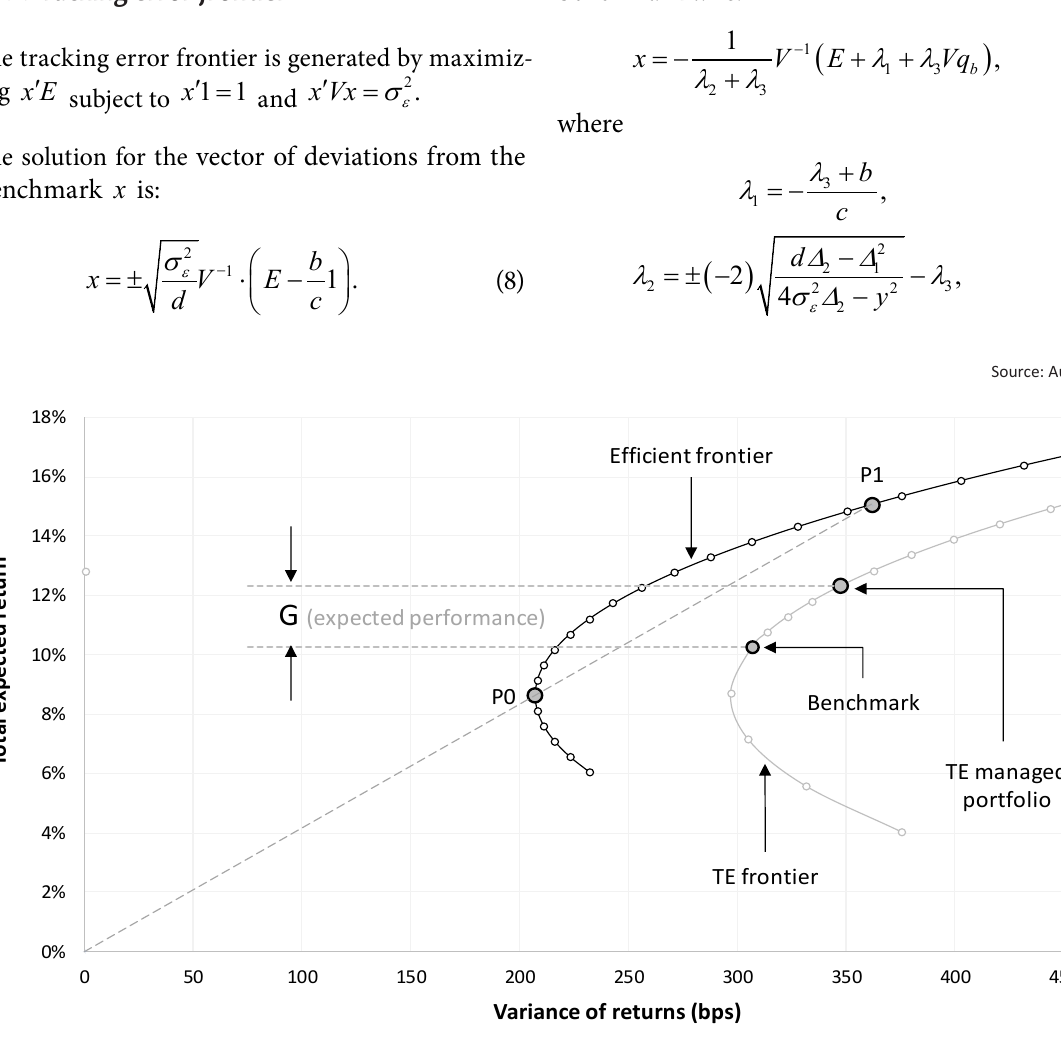
P and P on the efficient frontier and the gain , 0 1